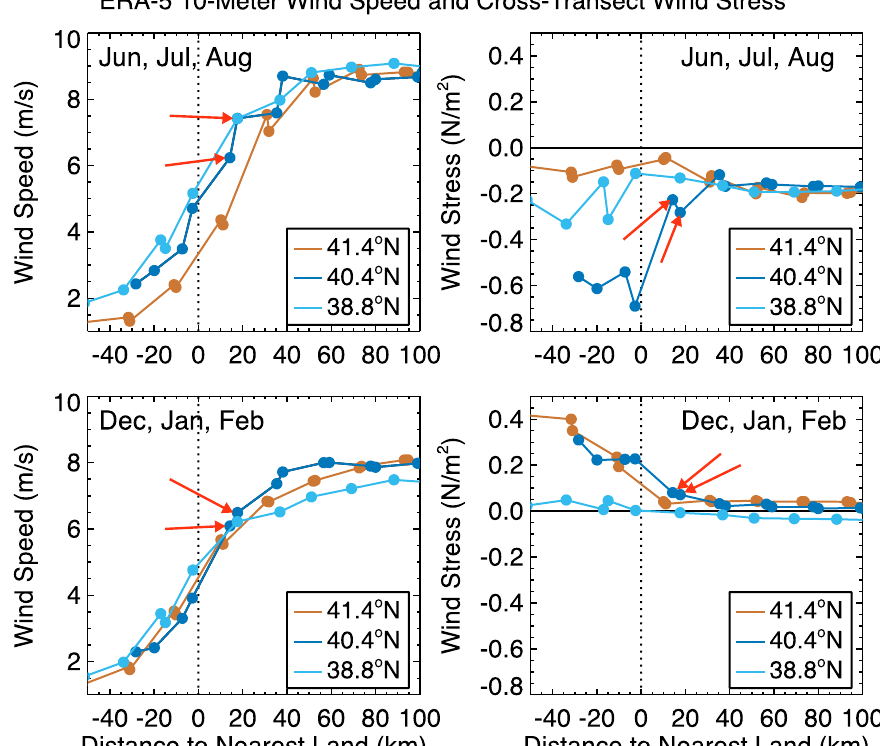
Figure 11. (Above, single panel) ERA-5 interpolated grid points surrounding three transects crossing the coast of northern California. Colors identify the transects and correspond to the colors of lines in the line plots. Red arrows point to two grid points over water just offshore of Cape Mendocino (40.4 ◦ N). (Below, four panels) ( Left ) Averages of the ERA-5 10-meter wind speed magnitude at the interpolated grid points shown in the map, as a function of the distance between the grid point and the nearest land (negative is distance over land to nearest coastline). ( Right ) Cross-transect wind stress at the same gridpoints. Three-month seasonal averages for the 10-year QuikSCAT period are shown for equatorward winds in summer ( top ) and poleward winds in winter (bottom). Red arrows point to data at the two grid points over water just offshore of Cape Mendocino (40.4 ◦ N). The transects are identified by the latitude of their coastal